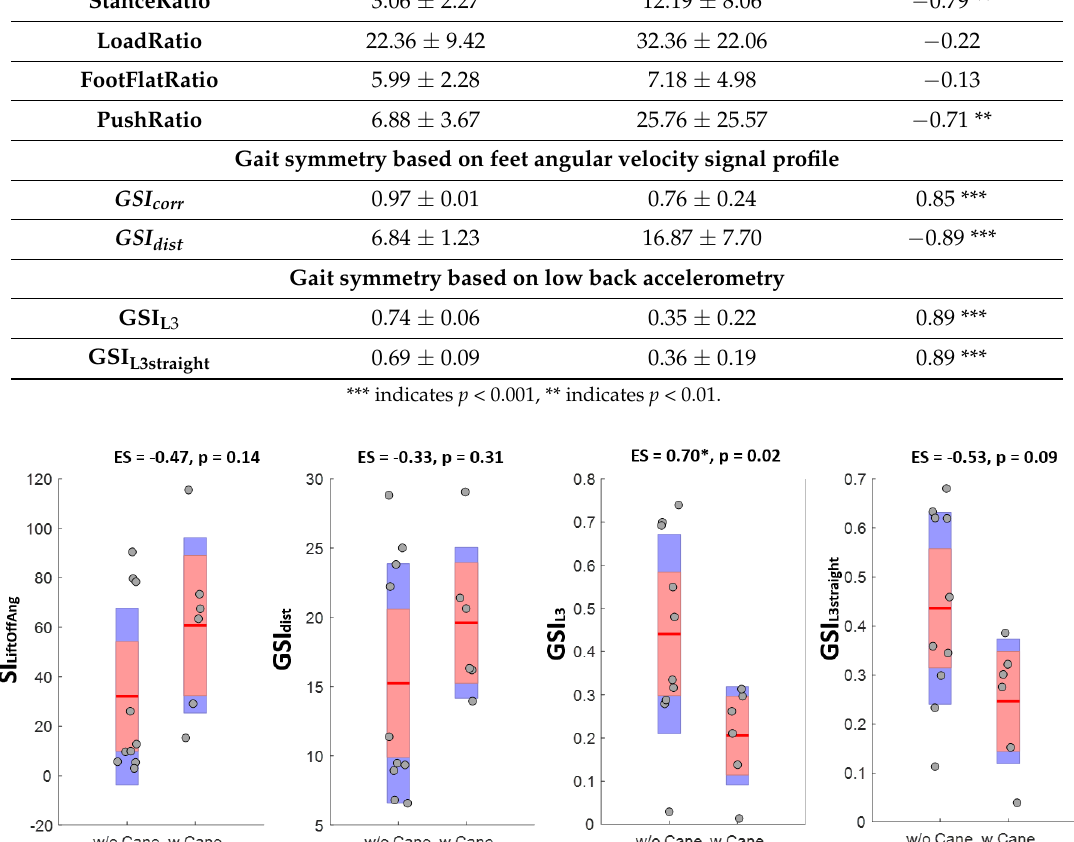
Table 2. Mean ± standard deviation and effect size (ES) as estimated by Cliff’s Delta of various symmetry indices.